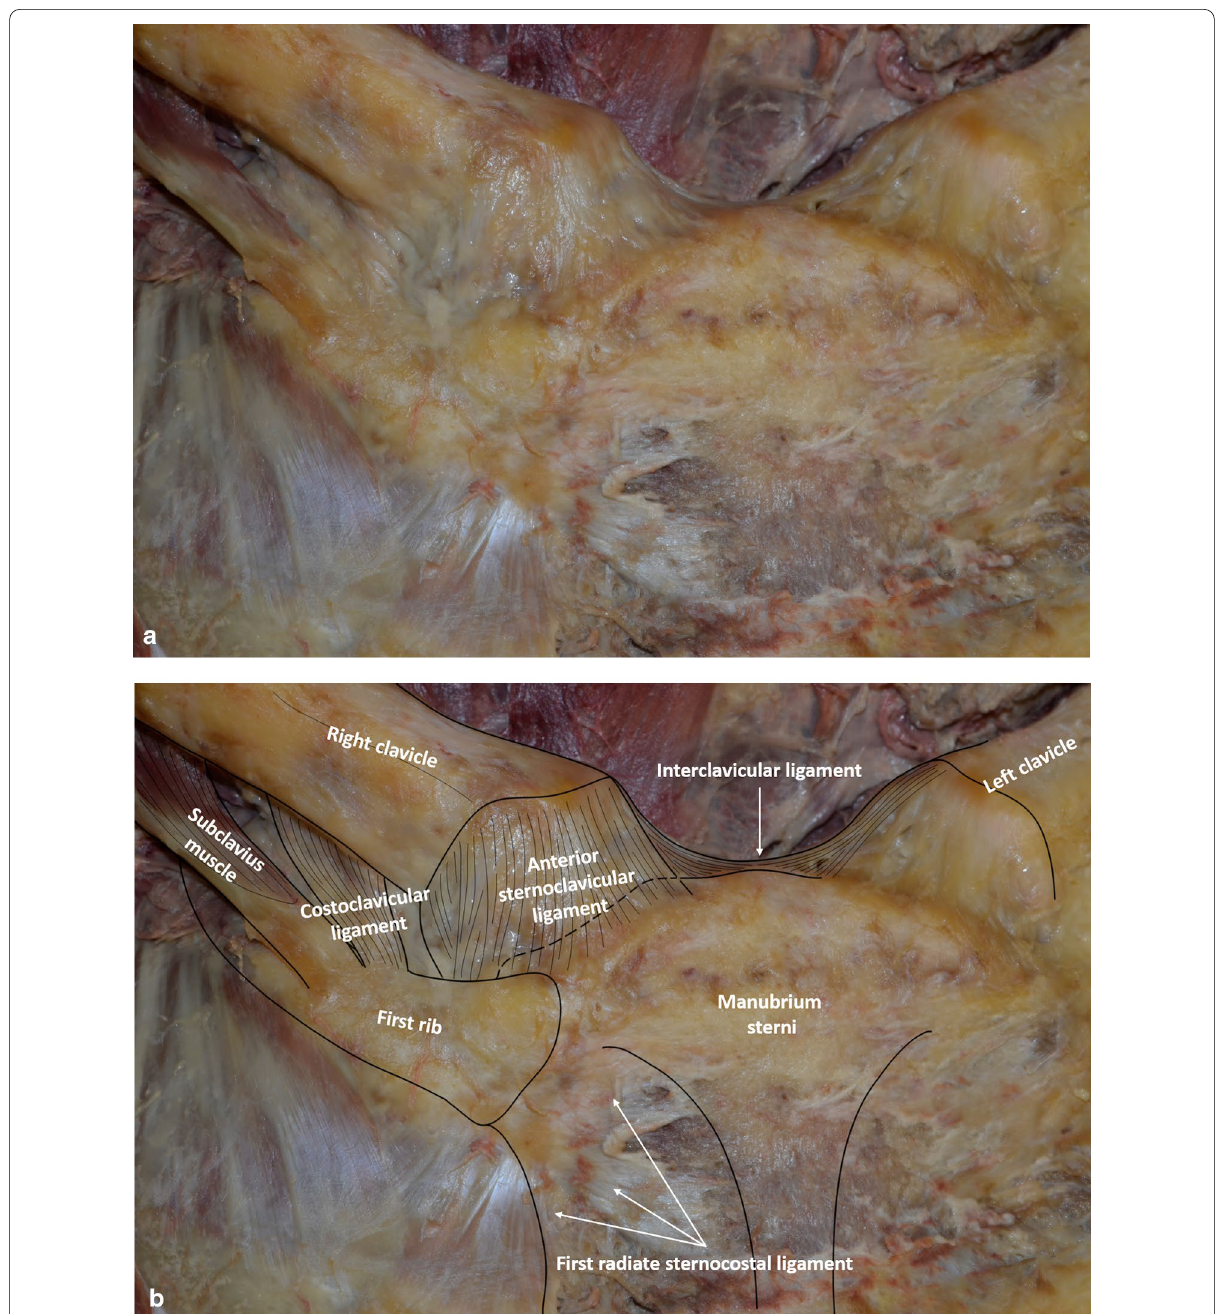
Fig. 2 Anterior view of the right sternoclavicular joint without ( a ) and with ( b ) annotations. The sternocleidomastoid tendons and the pectoralis major muscle have been removed, exposing the anterior sternoclavicular ligament, interclavicular ligament and costoclavicular ligament. c Anterior view of the right intra-articular disc (*) after removal of the anterior sternoclavicular capsuloligamentous structures. Note persistent anterior capsuloligamentous fibers inserted on both the disc and the first costal cartilage (small